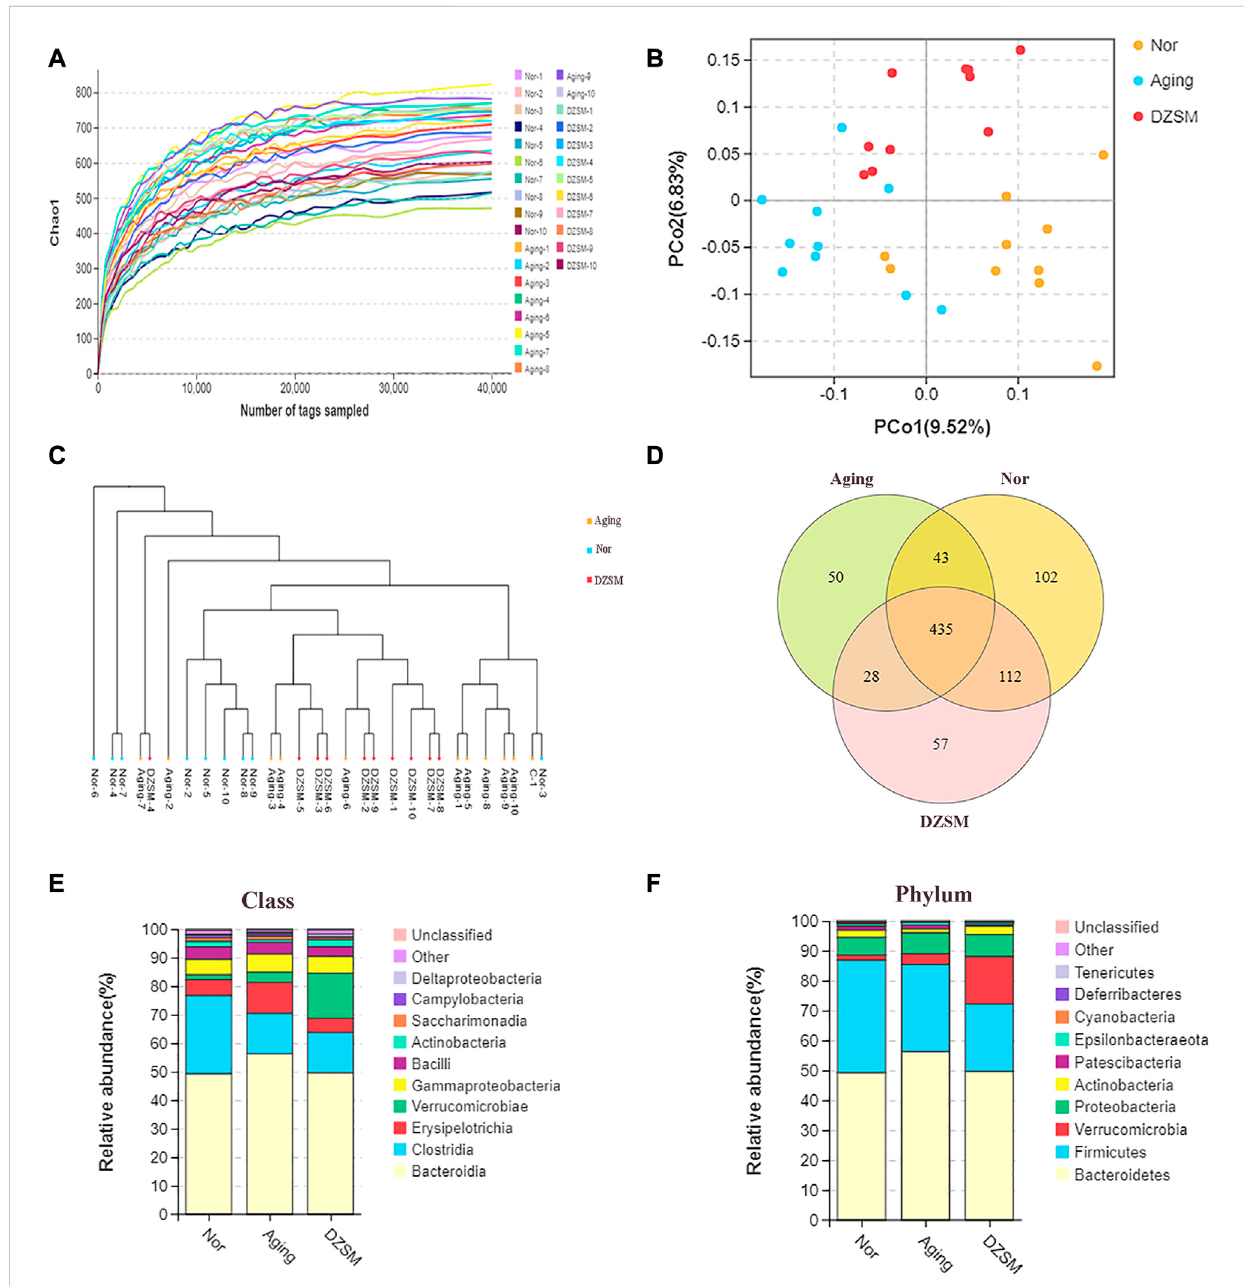
FIGURE 6 The intestinal microbiome determined by 16S rDNA. (A) Rarefaction curve of the chao1 index; (B) Unweighted UniFrac PCoA in which each dot representsthegutmicrobiotaofamouse; (C) Unweightedpairgroupmethodwitharithmeticmean(UPGMA)sampleclusteringtree; (D) Venndiagramof three groups indicates shared and special OTUs of Nor, Aging, and DZSM groups; (E,F) Intestinal microbial taxonomic composition of DZSM at the class and phylum